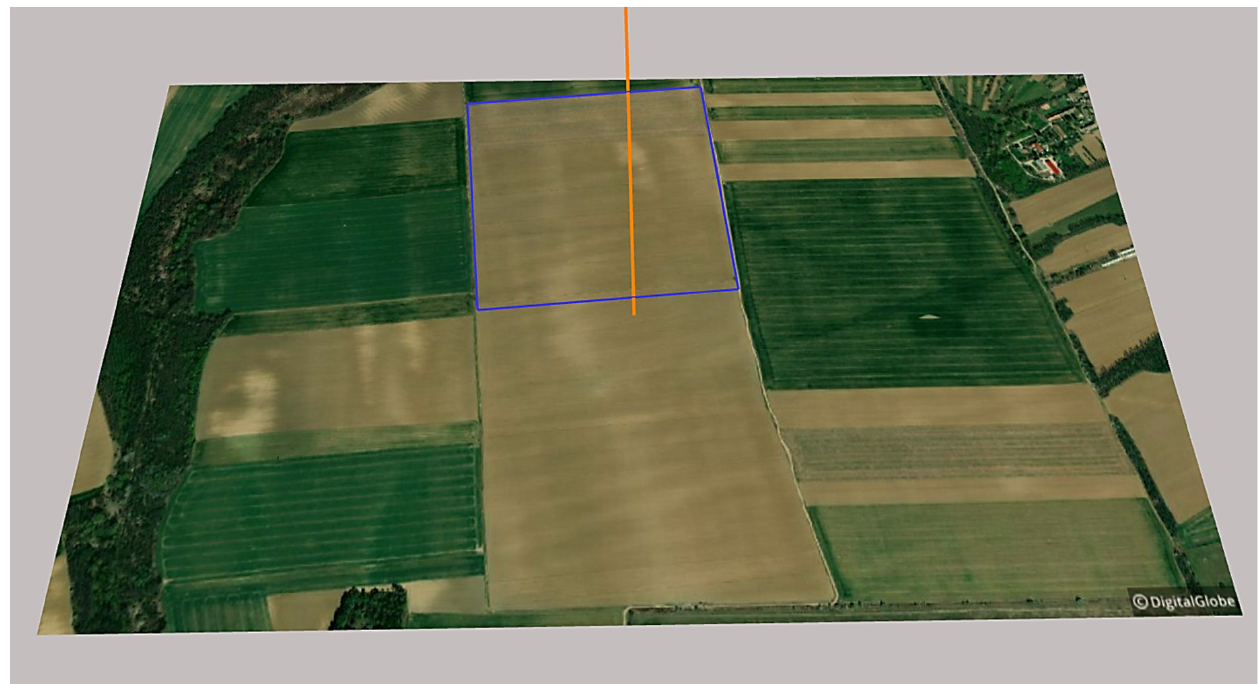
Figure 2. The site selected for modeling: Juta, 46.403736, 17.719469 (area with blue outlines: the examined 22.7 ha area; orange line: north), based on [54].